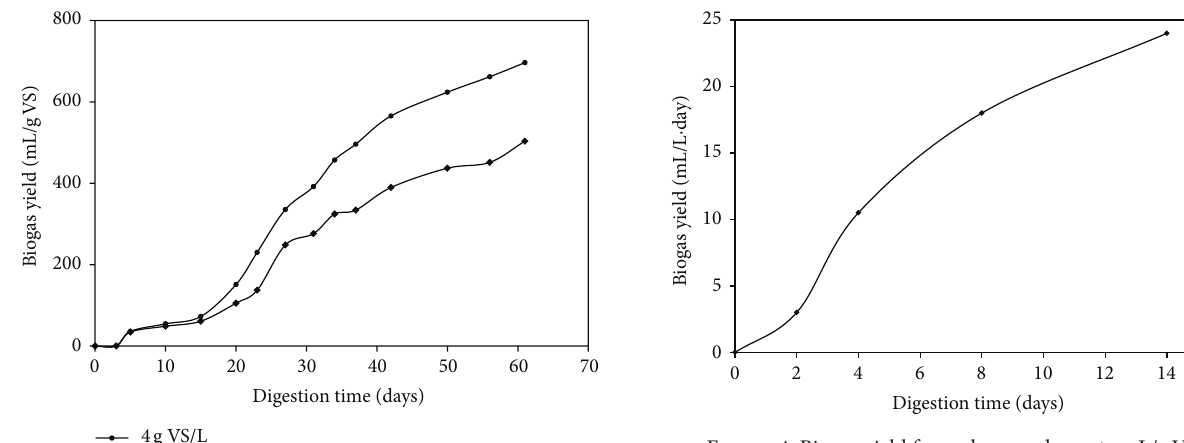
Figure 4: Biogas yield for cashew apple waste mL/gVS.